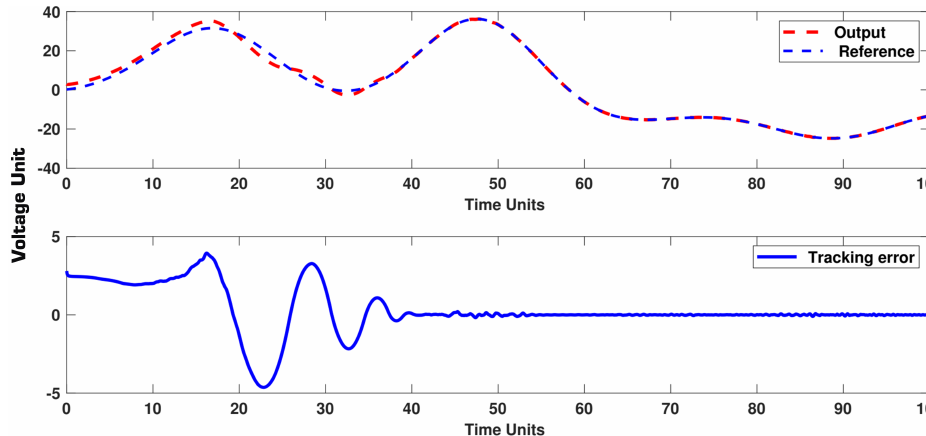
Figure 9. Example 2: Output and error signals, faulty condition.